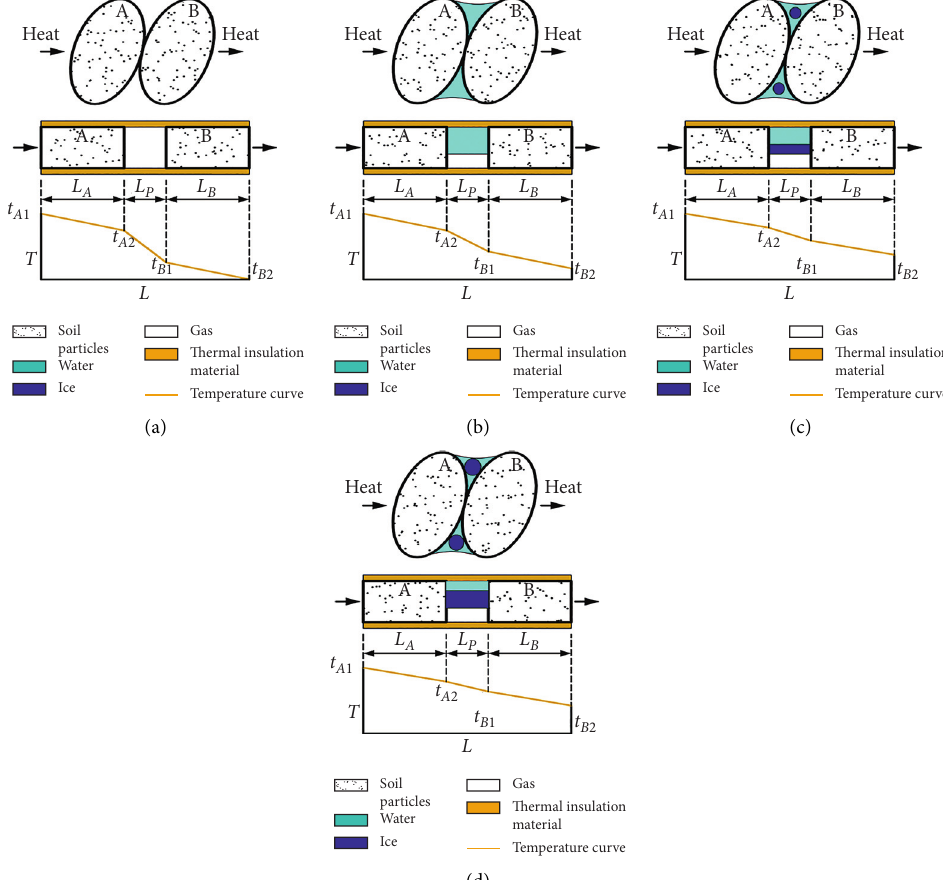
Figure 7: Schematic diagram of heat conduction between soil particles in different states: (a) dry soil; (b) wet soil at room (T); (c) early freezing stage of wet soil; (d) late freezing stage of wet